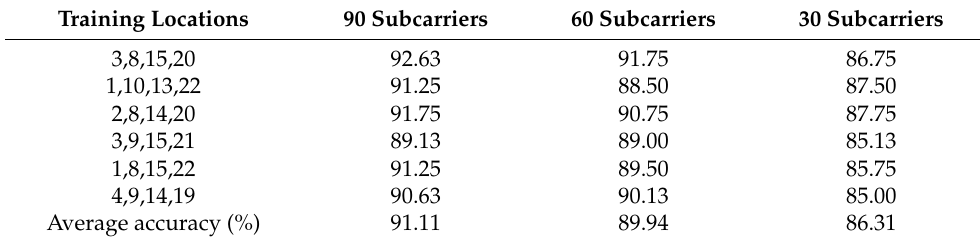
Table 5. The accuracy for different number of subcarriers with four training locations.